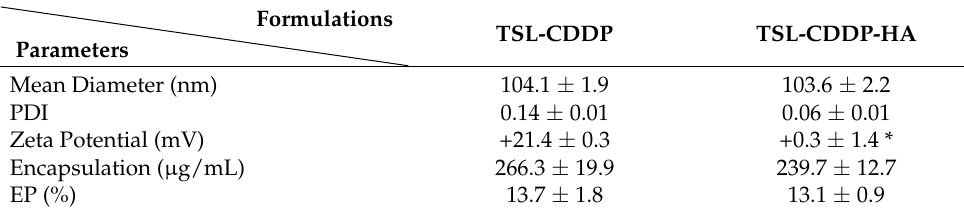
Table 1. Characterization of cisplatin thermosensitive